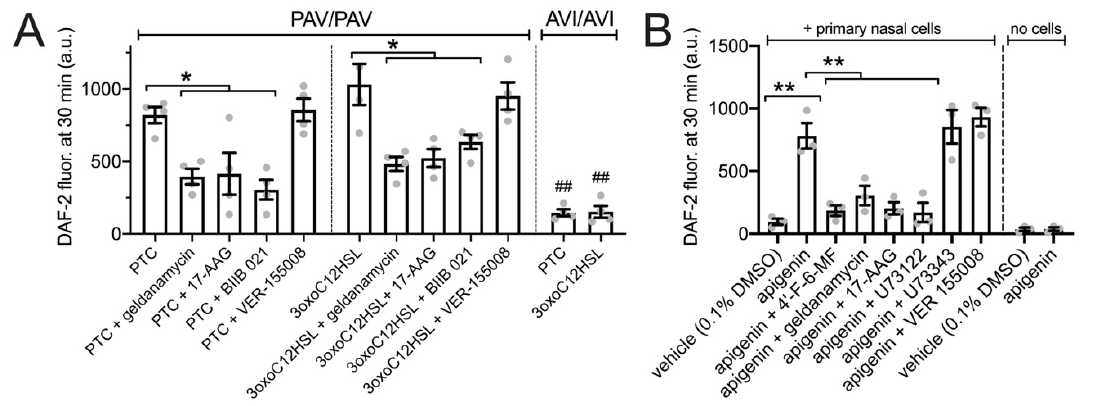
Figure 5. HSP90 inhibition reduces T2R-stimulated NO diffusion into the airway surface liquid (ASL) in primary sinonasal epithelial cells grown at the air–liquid interface (ALI) Experiments were performed as in Figure 2 to measure NO diffusion into the ASL but with primary nasal ALIs. ( A ): PTC (500 µM) or 3oxoC12HSL (100 µM) stimulated extracellular DAF-2 fluorescence in PAV/PAV and AVI/AVI cultures, as indicated. PAV/PAV cultures were also pretreated with HSP90 inhibitors geldanamycin, 17-AAG, or BIIB 021 or HSP70 inhibitor VER-155008. ( B ): shows experiments with apigenin ± 4 ′ -F-6-MF, geldanamycin, 17-AAG, or PLC inhibitor U73122 and inactive analogue U73343. Control Transwells containing no cells were similarly incubated with vehicle only or apigenin to test for any cell-independent reaction of apigenin with DAF-2. Significance by one way ANOVA with Bonferroni post-test; * p < 0.05 vs. bracketed bars; ** p < 0.01 vs. bracketed bars; ## p < 0.05 for the same condition in PAV/PAV vs AVI/AVI cultures.